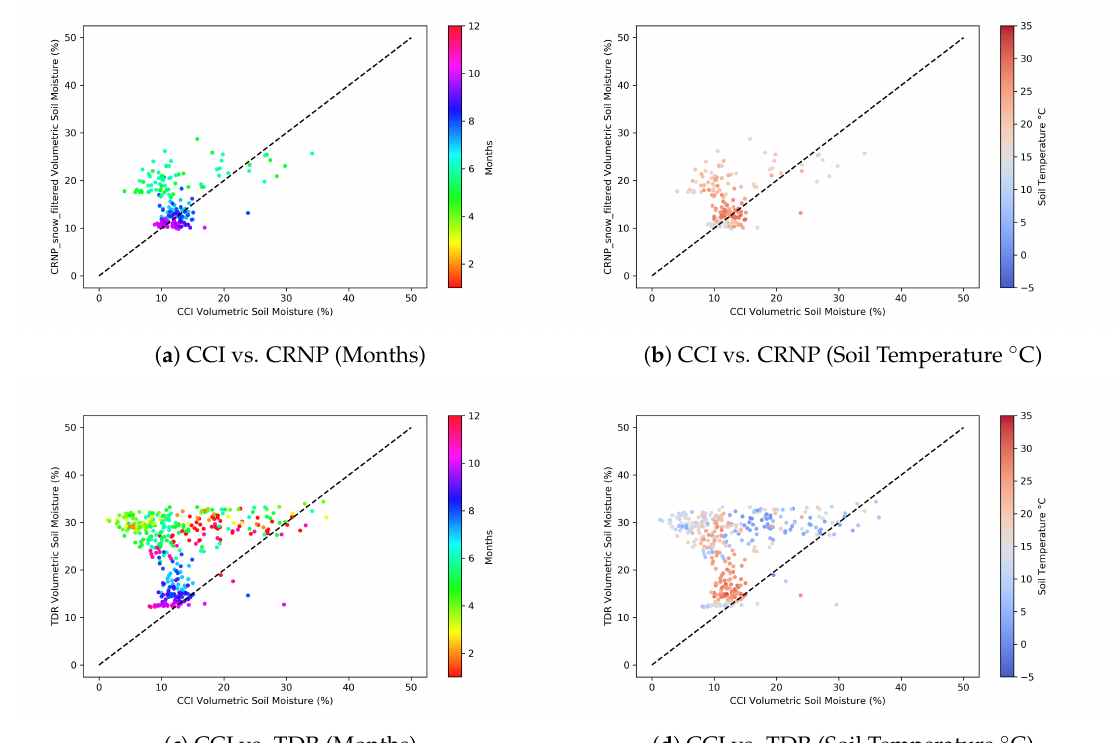
Figure A6. Comparisons between CCI Soil Moisture Product with CRNP and